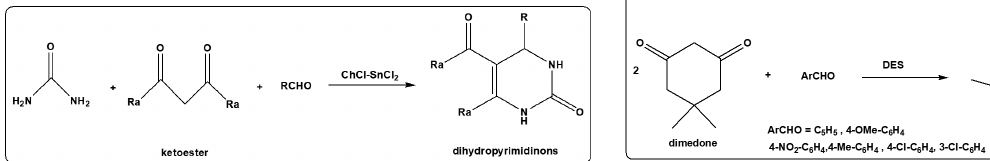
catalysed synthesis of dihydropyrimidinons. h Figure 12: ChCl-SnCl 2 h See Azizi et al. [72] for detailed reaction components and conditions.